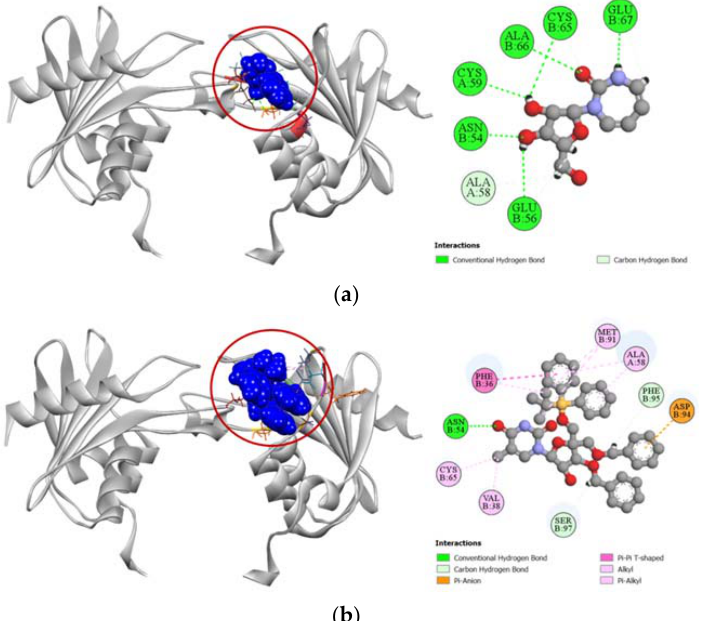
interactions of compound 6 with potent inhibitor 1-beta-ribofuranosyl-1,3-diazepinone, where it can be seen that they both dock with ASN54 and ALA58 residues.